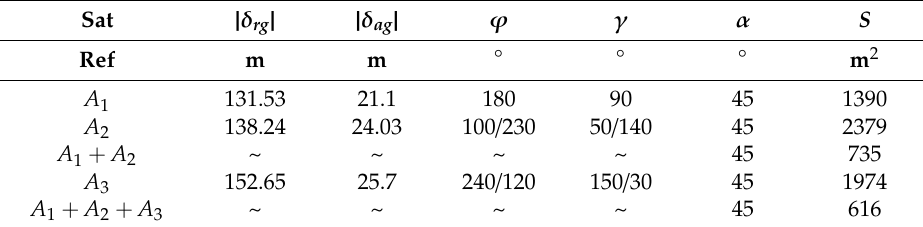
Table 2. Simulated MPSF 2-D resolution unit area ( m = 2 and m =